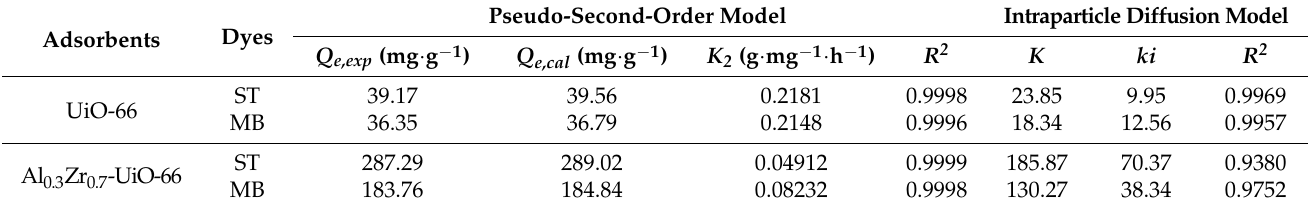
Table 3. Kinetic parameters of the pseudo-second-order and intraparticle diffusion models for ST and MB